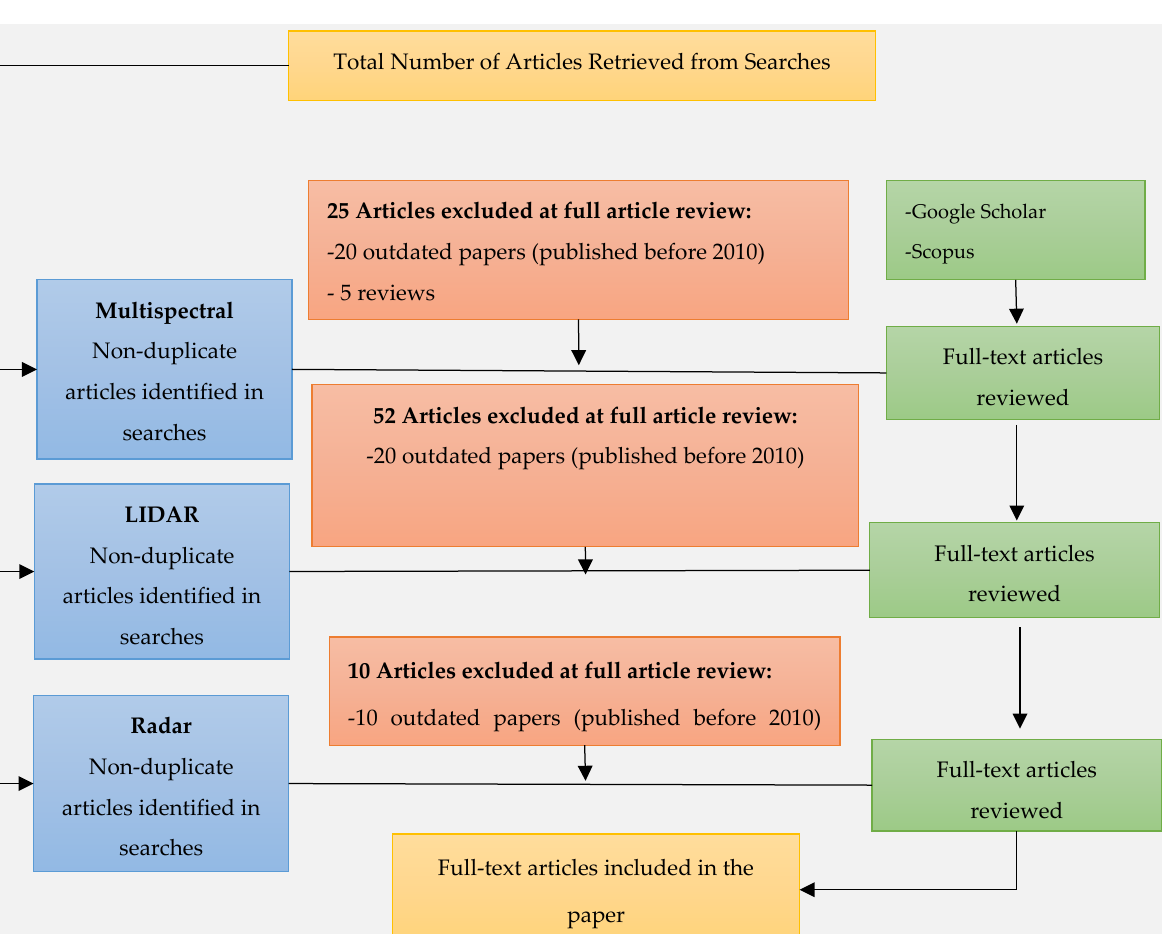
Figure 2. The Detailed Screening Process.